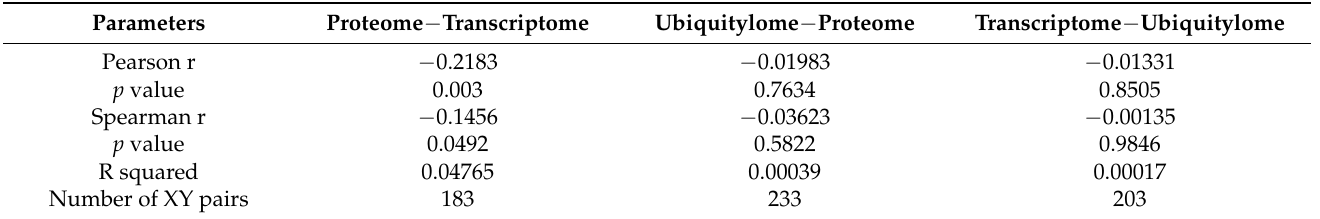
Table 1. Correlation coefficients for comparison of changes in protein, ubiquitin, and RNA levels in response to HBV infection.